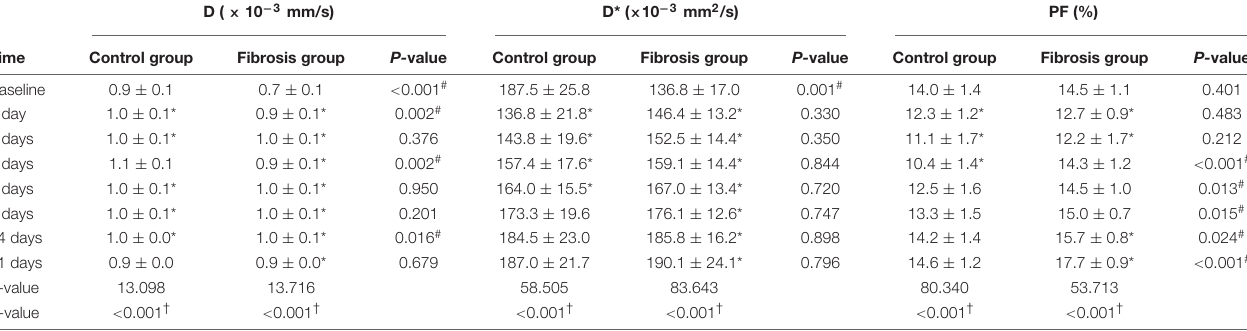
TABLE 1 | Comparison of IVIM parameters in control and fibrotic liver tissue groups after left lateral lobe resection. D ( × 10 − 3